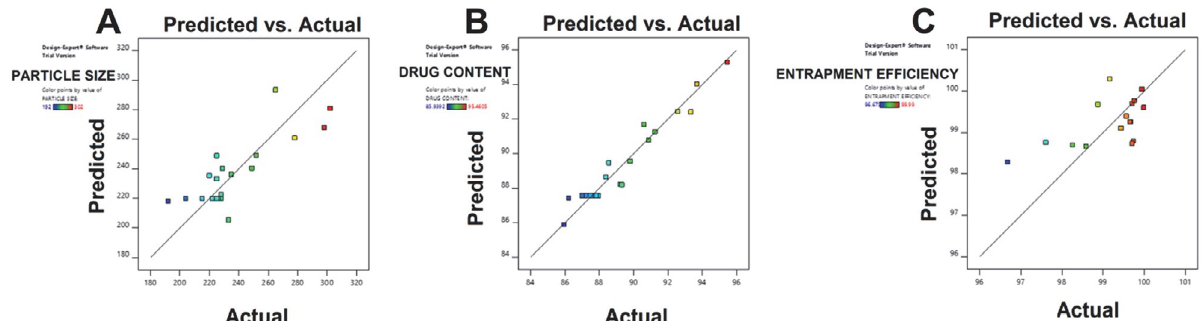
Figure 6. Liner correlation plots between actual and predicted values of responses: a) particle size (nm), B) drug content (%), C) entrapment efficien- cy (%).